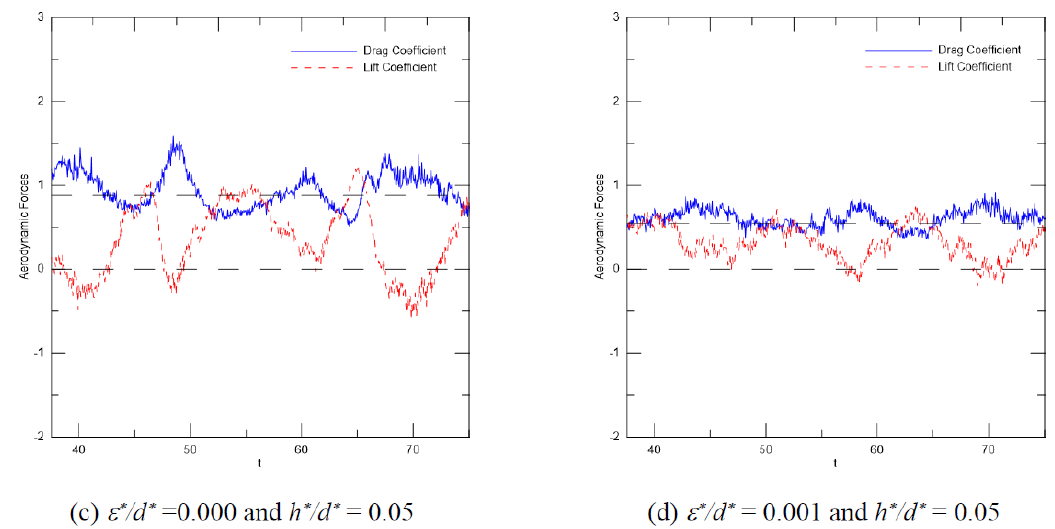
Figure 5. Temporal history of the drag and lift coefficients for the circular cylinder in the vicinity of a moving wall ( Re = 1.0 × 10 5 ).